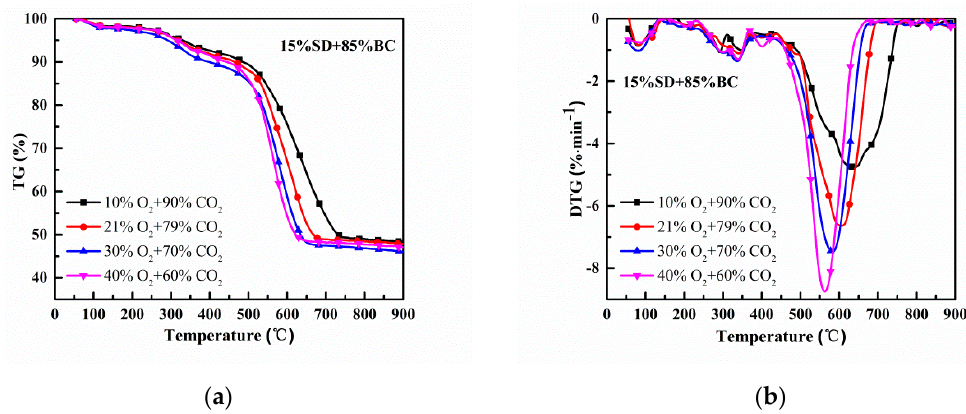
Figure 4. Thermo-gravimetric curves of the experimental samples at different O 2 concentrations. ( a ) TG curve; ( b ) DTG curve.